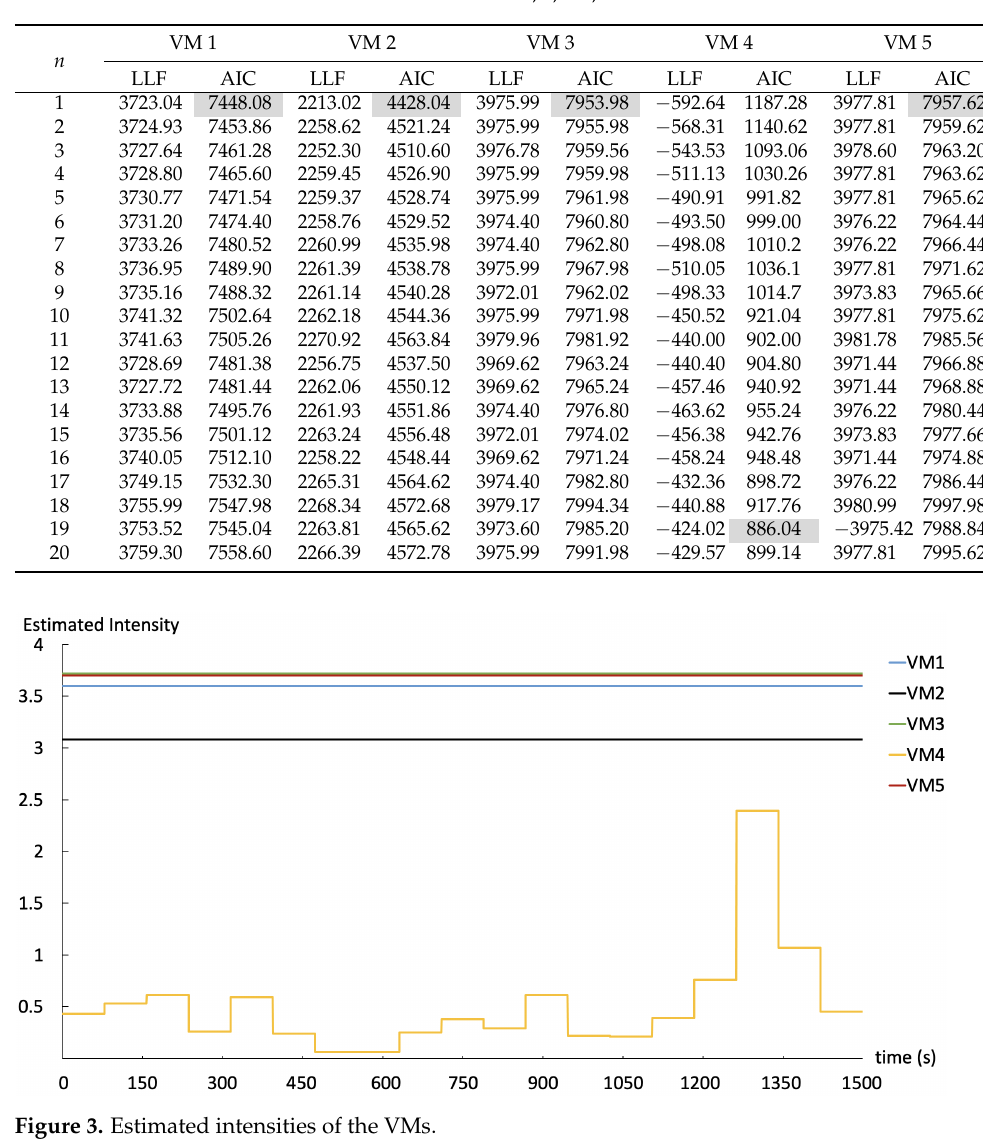
Table 2. AIC values of the NHPP models with n = 1,2, . . . ,20 for the five VMs.